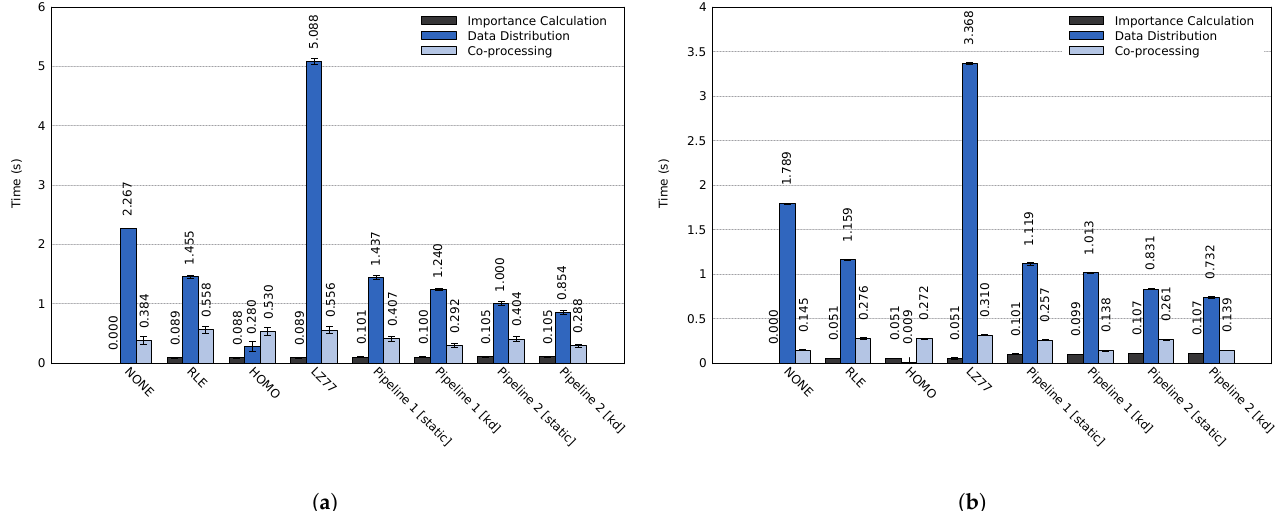
Figure 11. Average time step execution time for the three main stages using all three data sets on ( a ) cluster A and ( b ) cluster B. The error bars display the standard deviation of the computation times.